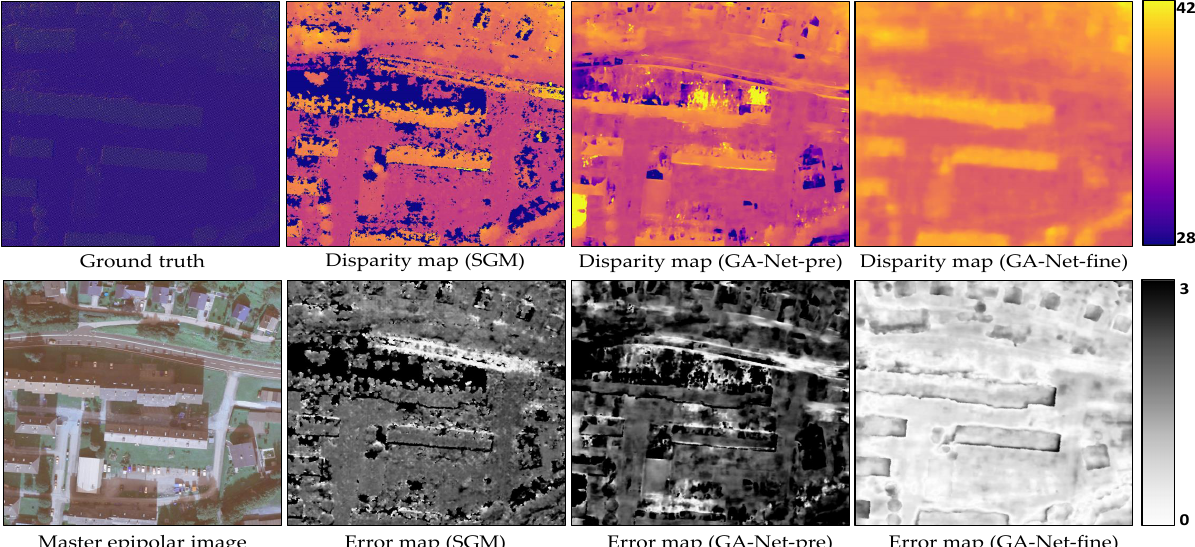
Figure 2. Experiment I: The results of SGM, pre-trained GA-Net and finetuned GA-Net from Experiment II